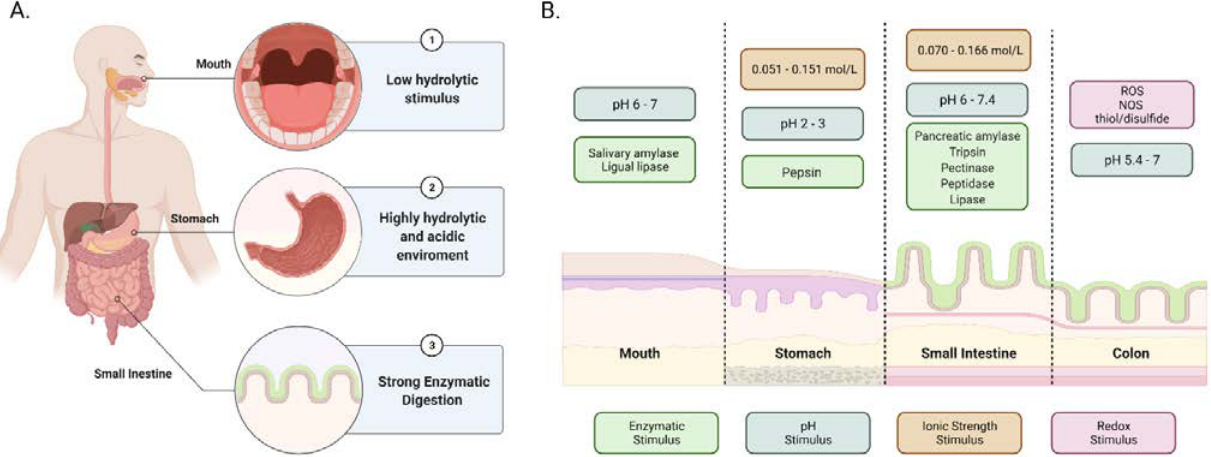
Figure 1. Main GIT components ( A ) and intrinsic exploitable stimuli ( B ) are considered when fabricating novel stimuli-responsive platforms for probiotics encapsulation and targeted delivery. Colored boxes correspond to enzymatic (green), pH (blue), ionic strength (orange), and redox (purple) stimuli.